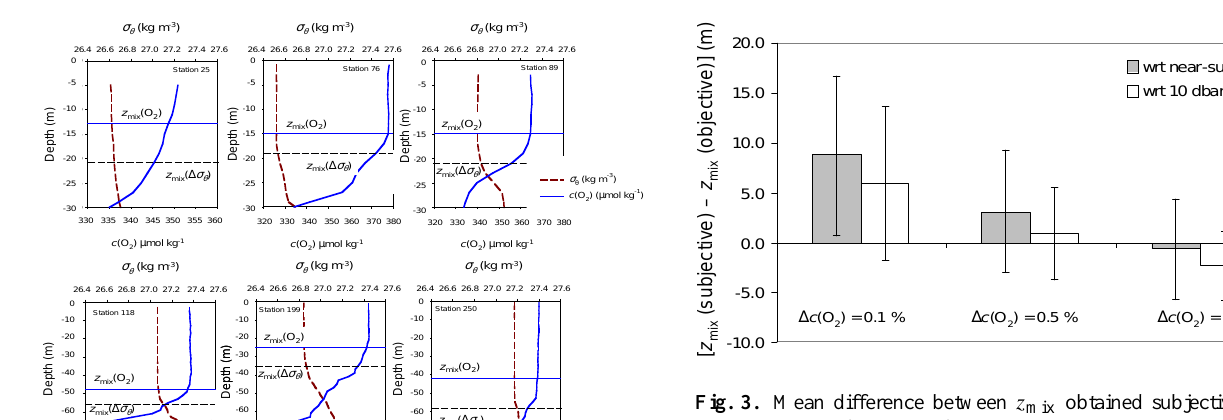
Fig. 3. Mean difference between z mix obtained subjectively (by visual inspection) and z mix (O 2 ) obtained using three threshold cri- teria with two different reference depths: (1) 0.1%, (2) 0.5% and (3) 1.0%, with respect to c (O 2 ) in near-surface water ( ≈ 2dbar) and at